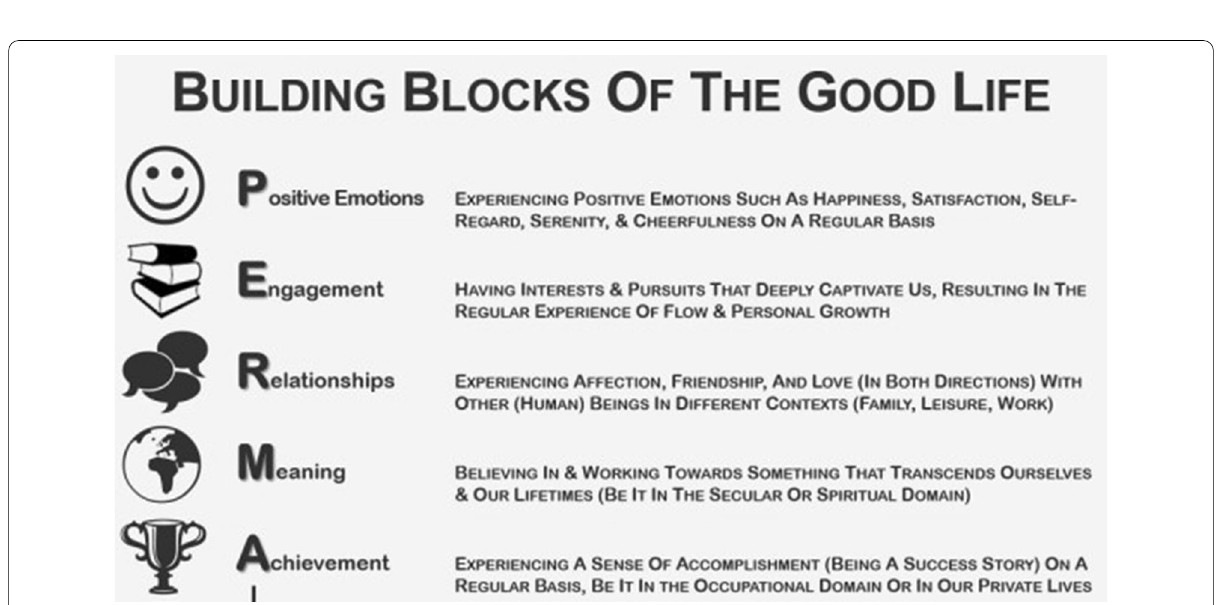
Fig. 1 PERMA theory of well‑being by Seligman